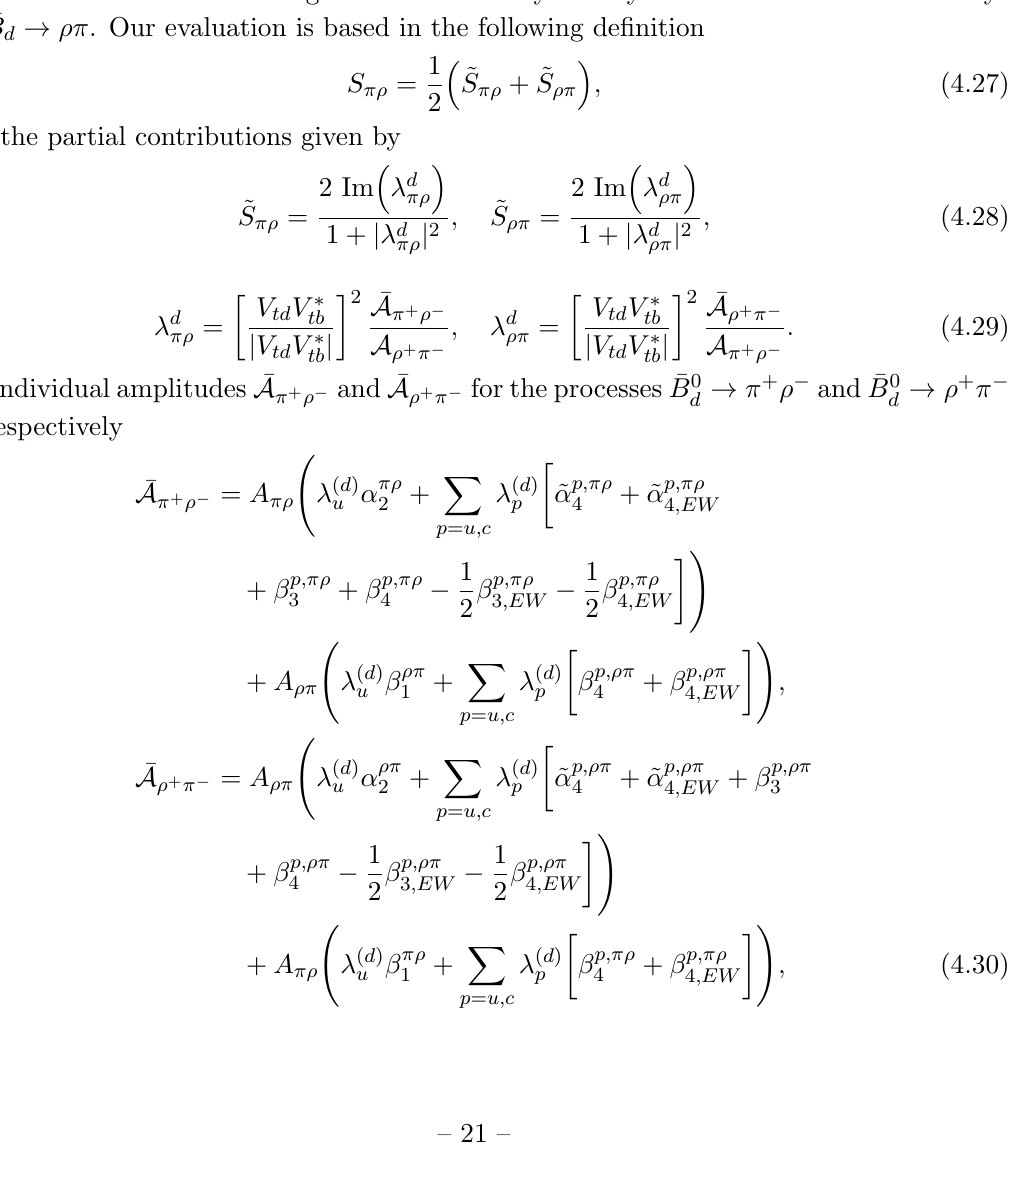
Figure 8 . Potential regions for the NP contributions in (cid:1) C d;uu S (cid:25)(cid:25) at 90% C.L., the shift in the Wilson coe(cid:14)cient (cid:1) C d;uu therefore not shown. The black point corresponds to the SM